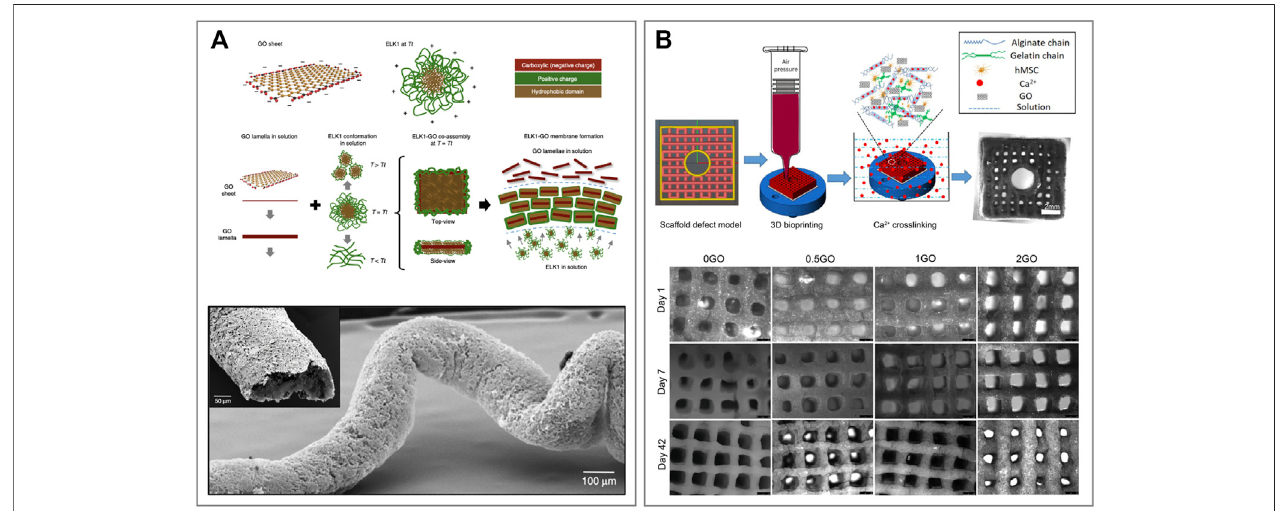
FIGURE6| 3Dprintedgrapheneoxide-basedbiomaterials (A) SchematicrepresentationofaGOsheetandELK1atitstransitiontemperature( Tt =30 ° C)indicating thecharged(redandgreen)andhydrophobic(brown)partsofbothcomponents.TheproposedassemblymechanismshowingtheconformationofGOandELK1before andafterco-assembly.Imagesofthe3DprintedGO-ELK1materialforthefabricationof fl uidicdeviceswithtubularstructure.Reprintedwithpermission(Wuetal.,2020). (B) Schematic illustration of 3D bioprinting pipeline and the 3D cell-laden defect scaffolds (top). Images of the 3D cell-laden defect scaffolds with different GO contents and cultured in the osteogenic media for 1, 7 and 42 days (bottom). Reprinted with permission (Zhang et al., 2021).